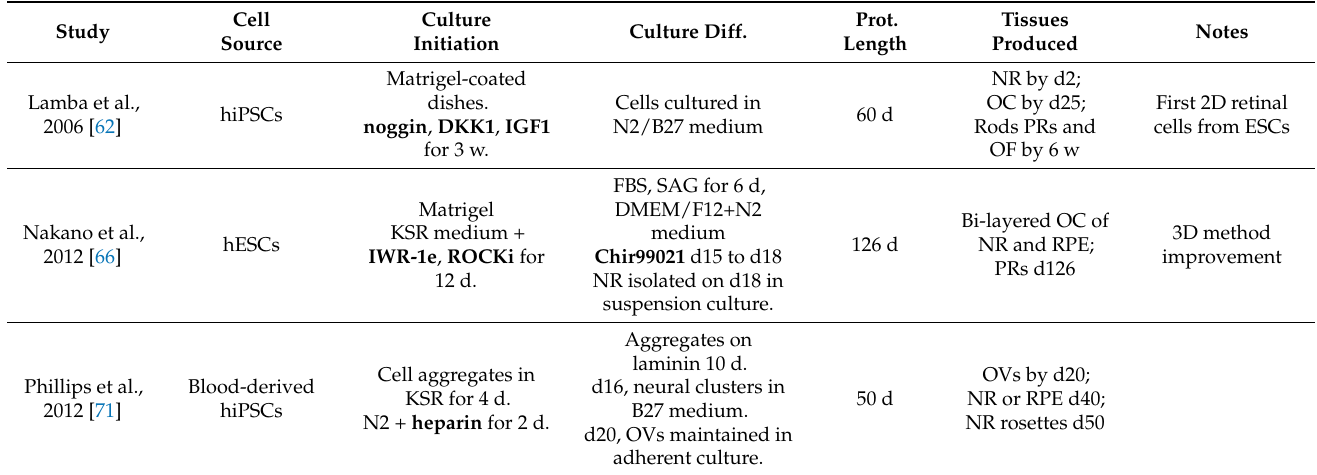
Table 2. Summary of the key protocols developed to differentiate pluripotent stem cells to three- dimensional (3D) retinal organoids: hiPSC (human induced pluripotent stem cells); ESCs (embryonic stem cells); PR (photoreceptors); NR (neural retina); NRVs (neuroretinal vesicles); RPE (retinal pigment epithelium); EB (embryoid bodies); KSR (knock-out serum replacement); CC